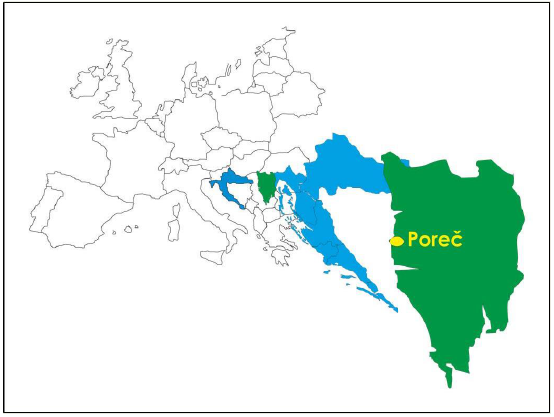
Figure 2. Geographical location of study area.